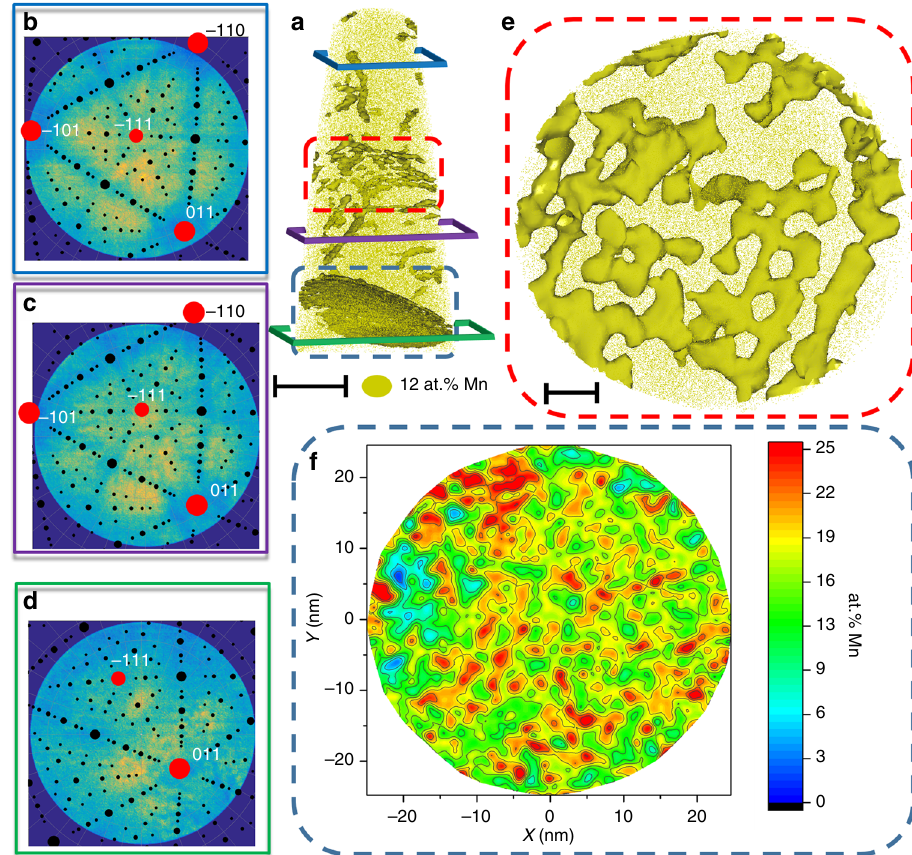
Fig. 2 APT analysis of a grain boundary decorated with Mn after 6 h at 450 °C. a The 12.5 at.% Mn iso-concentration surfaces (12.5 atomic % Mn was chosen as a threshold value to highlight Mn-enriched regions). Scale bar, 40 nm. b – d The detector map of the regions marked by the blue, purple, and green frames in a , respectively. The corresponding stereographic projections (black dots) after identi fi cation of the main poles in the map (red dots) were superimposed. e Detail of the twisted LAGB marked by the red dashed box in a as revealed by the iso-concentration surfaces. Scale bar, 10 nm. The grain boundary highlighted by the blue dashed box in a was exported and displayed in f using an in-plane concentration analysis inside the grain boundary